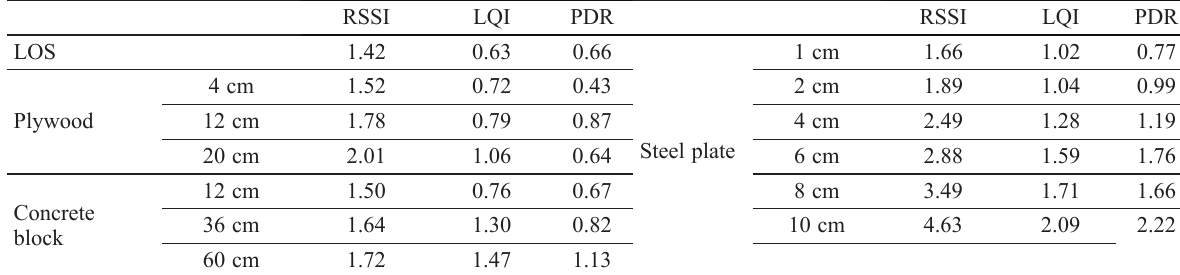
Table 2. Attenuation Index (AI) for different materials and thicknesses